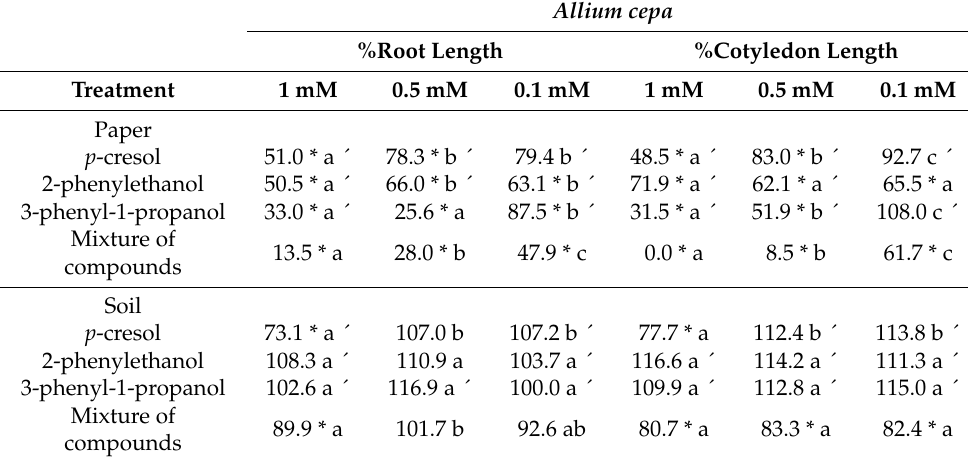
Table 3. Effect of different concentrations of phenolic compounds from the Cistus ladanifer exudate on Allium cepa root length and cotyledon, expressed as the percentage relative to the control. Four replicates of each treatment ( n = 4 × 50 = 200 seeds in total for each solution).